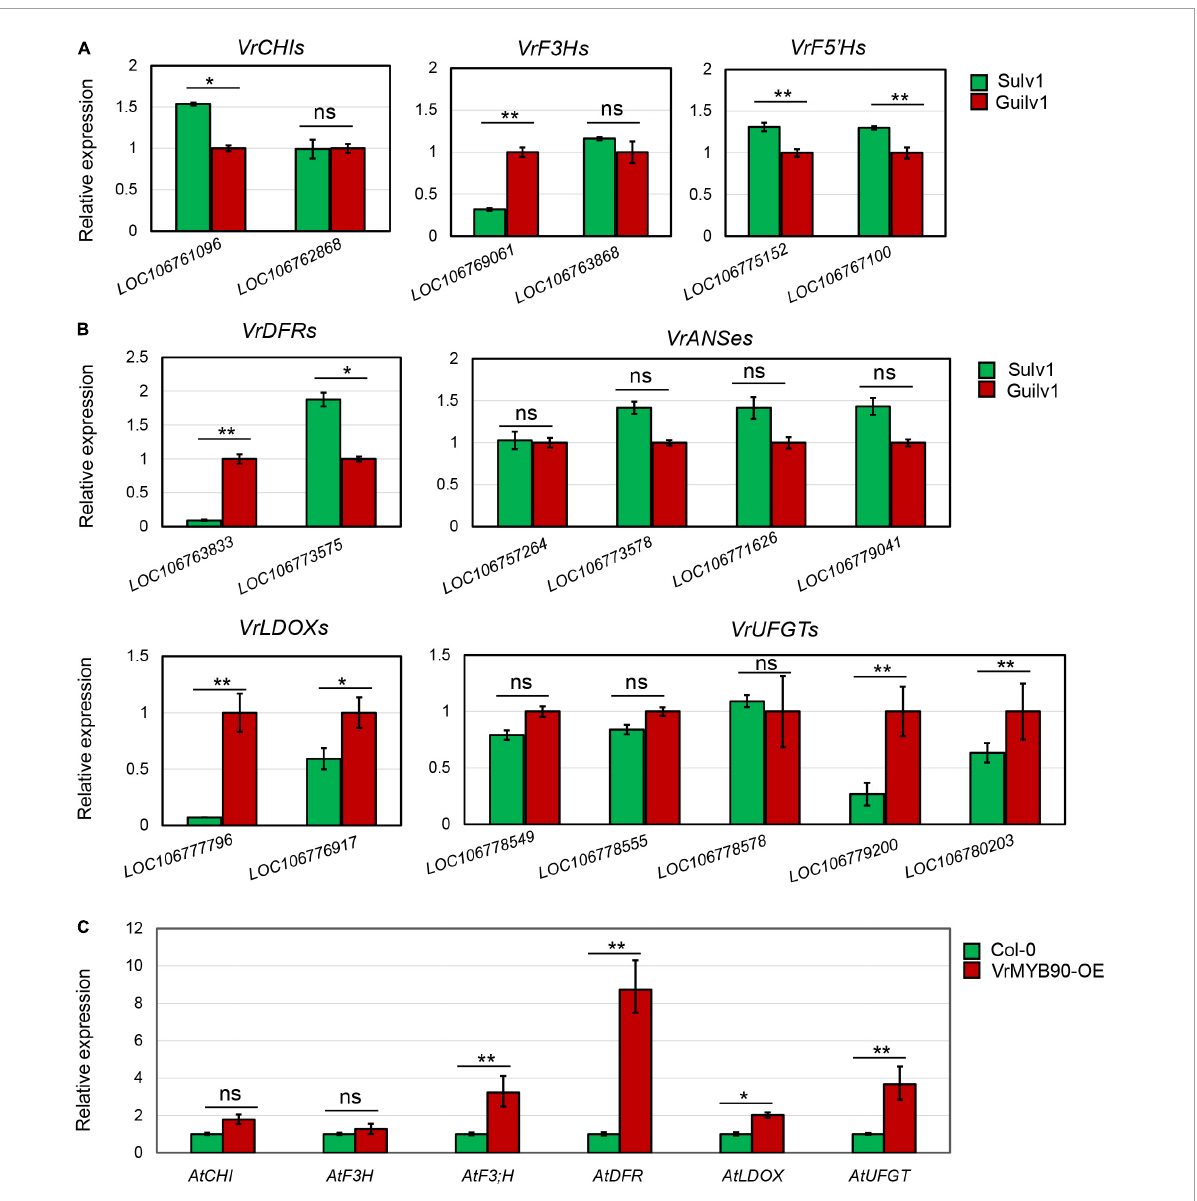
FIGURE7 Expression analysis of anthocyanin synthesis genes. (A,B) Expression analysis of EBGs (A) and LBGs (B) in the hypocotyls of Guilv1 and Sulv1. The gene expression in Guilv1 was set as a control. (C) Expression analysis of anthocyanin synthesis-related genes in VrMYB90 over-expression Arabidopsis thaliana . The gene expression in wild type (Col-0) was set as a control. * and ** indicate a significant difference by Student’s t -test ( P < 0.05 and P < 0.01,